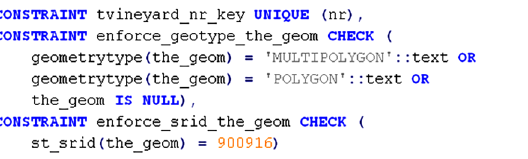
Figure 9. Constraints / conditions on the geometric